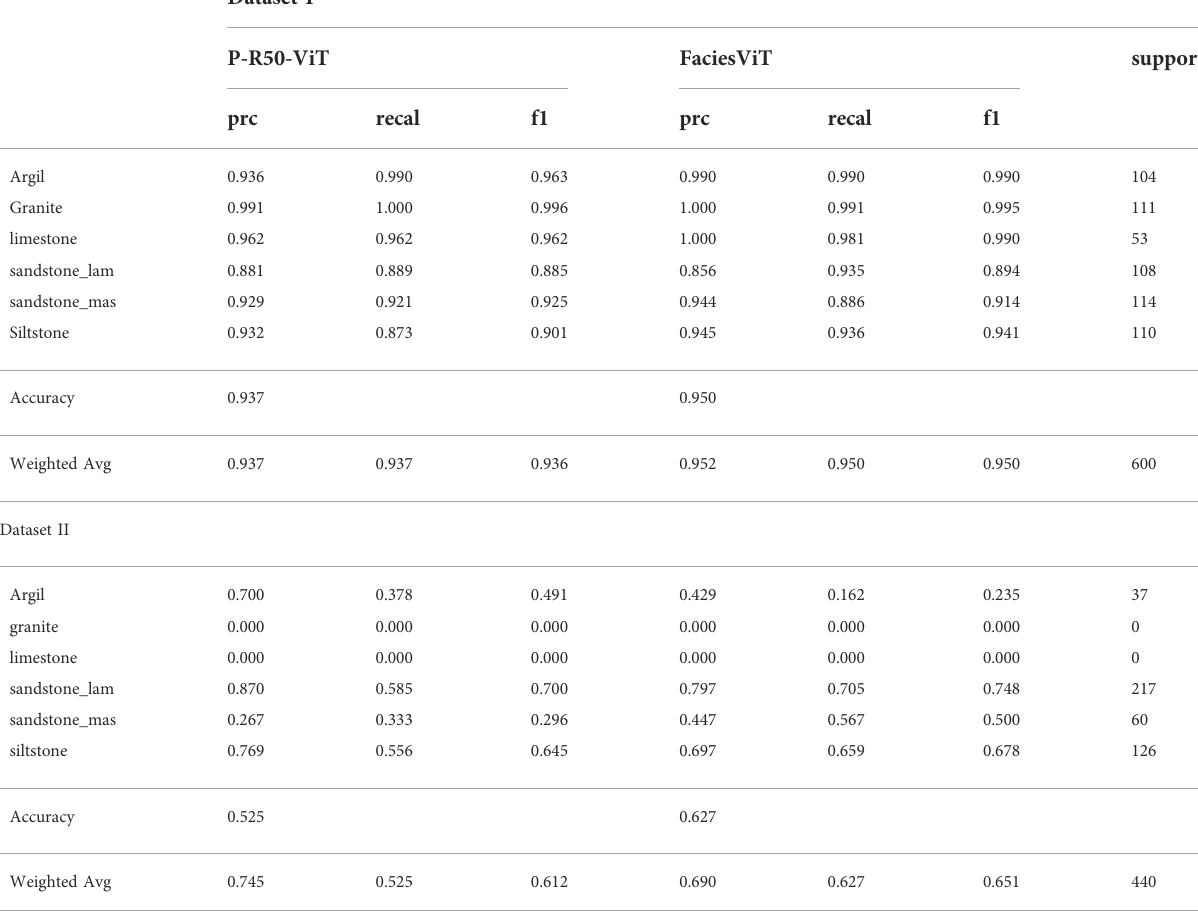
TABLE 5 Classi fi cation reports for ViT-based models for Dataset I and Dataset